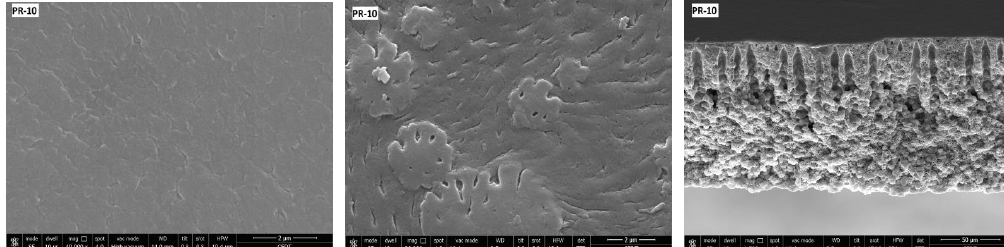
Figure 10. FESEM images of blended PVDF membranes films. Components of the dope solution: 15 wt % Solef ® 6020 PVDF homopolymer, 10 wt % Solef 90 ® 21015 PVDF copolymer, 75% wt mixture of